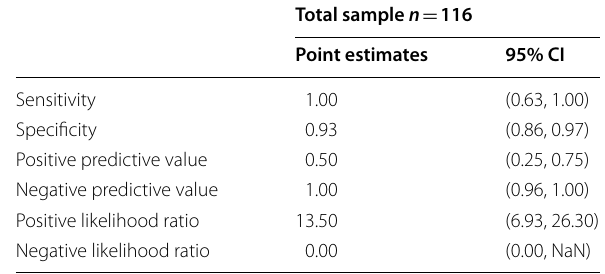
Table 4 Performance of the 4AT in delirium detection compared to the